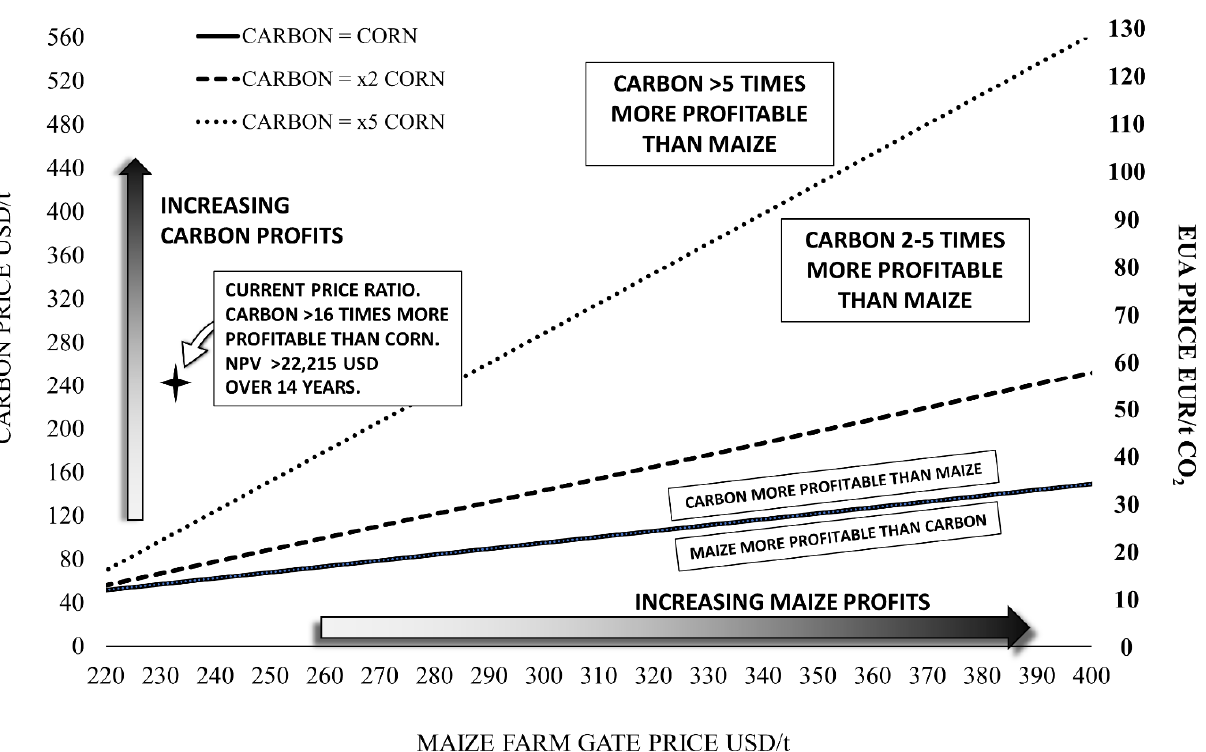
Figure 5. Relative profitability of maize or carbon with various price ratios. (The star indicates the current price ratio).